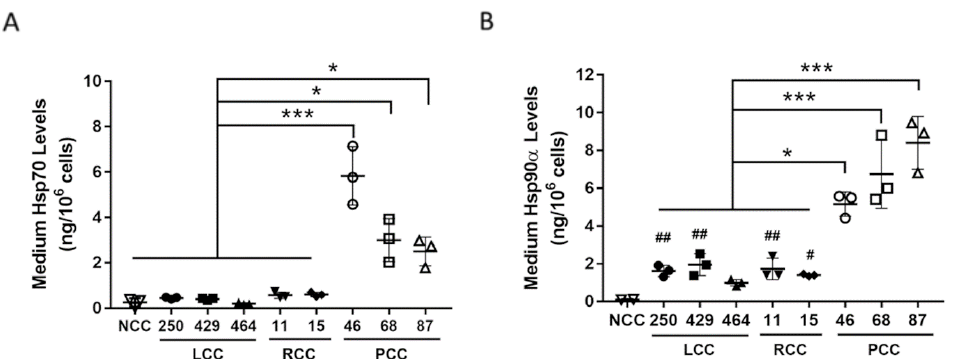
Figure 1. PCC releases markedly higher levels of Hsp70 and Hsp90 than LCC and RCC. Forty-eight- hour culture media of NCC, LCC, RCC, and PCC cells were analyzed for content of ( A ) Hsp70 and ( B ) Hsp90a using ELISA. Data (means ± SD) from 3 independent experiments were analyzed by one-way ANOVA followed by Bonferroni ’ s multiple comparison test. # denotes difference from NCC, and * denotes difference from LCC and RCC at p < 0.05. ## and ** denote p < 0.01. *** denotes p < 0.001.